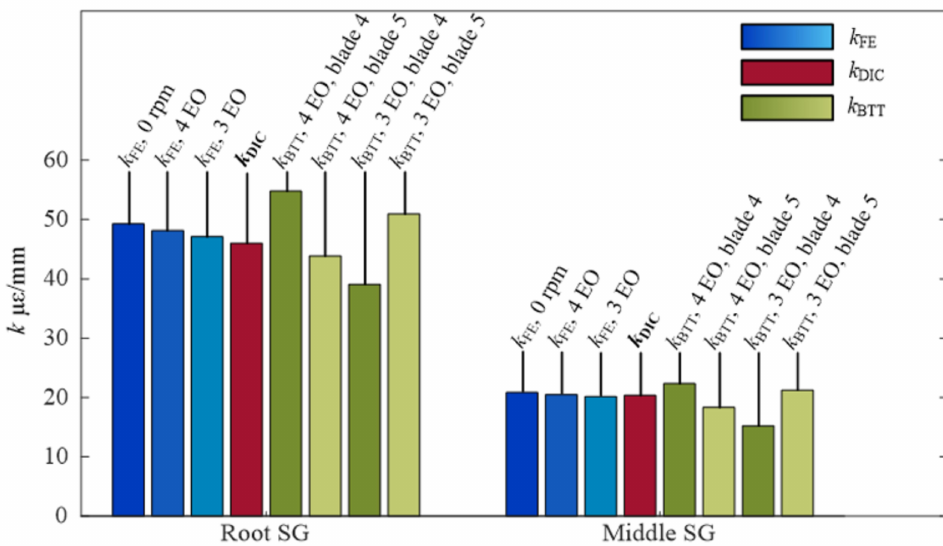
Figure 15. Ratio k of blade strain to tip displacement at the first order of mode